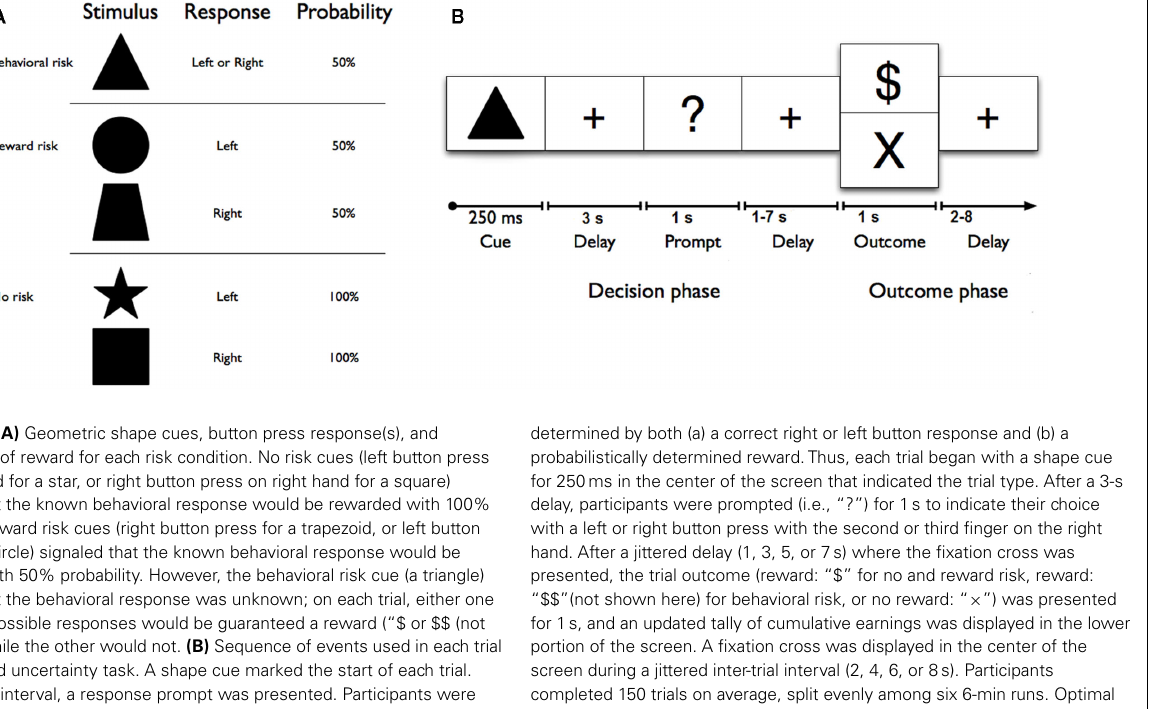
FIGURE 1 | (A) Geometric shape cues, button press response(s), and probabilities of reward for each risk condition. No risk cues (left button press on right hand for a star, or right button press on right hand for a square) signaled that the known behavioral response would be rewarded with 100% certainty. Reward risk cues (right button press for a trapezoid, or left button press for a circle) signaled that the known behavioral response would be rewarded with 50% probability. However, the behavioral risk cue (a triangle) signaled that the behavioral response was unknown; on each trial, either one of the two possible responses would be guaranteed a reward (“$ or $$ (not shown))” while the other would not. (B) Sequence of events used in each trial of the reward uncertainty task. A shape cue marked the start of each trial. After a fixed interval, a response prompt was presented. Participants were asked to press one of two buttons using their right hand as soon as the prompt appeared to make their choice.The outcome of each trial was